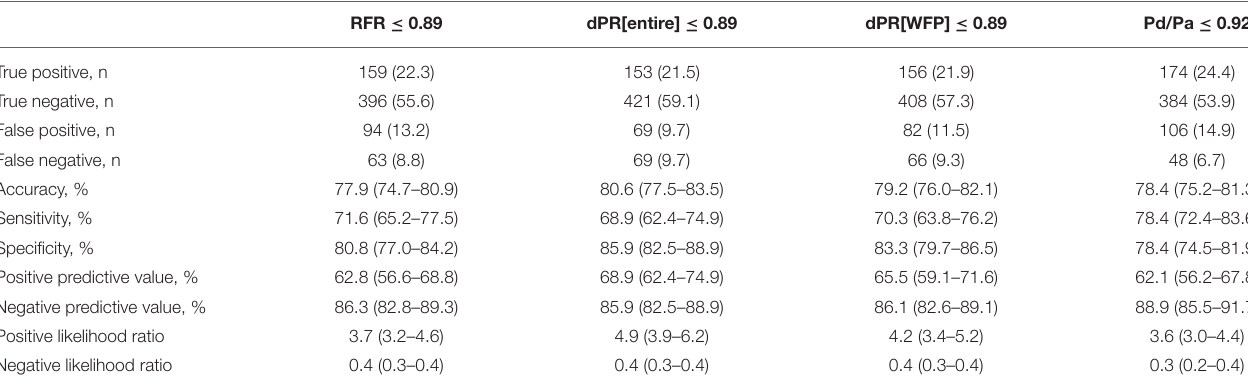
TABLE 2 | Diagnostic performance of non-hyperemic pressure ratios for predicting FFR ≤ 0.80 at vessel level. RFR ≤ 0.89 dPR[entire] ≤